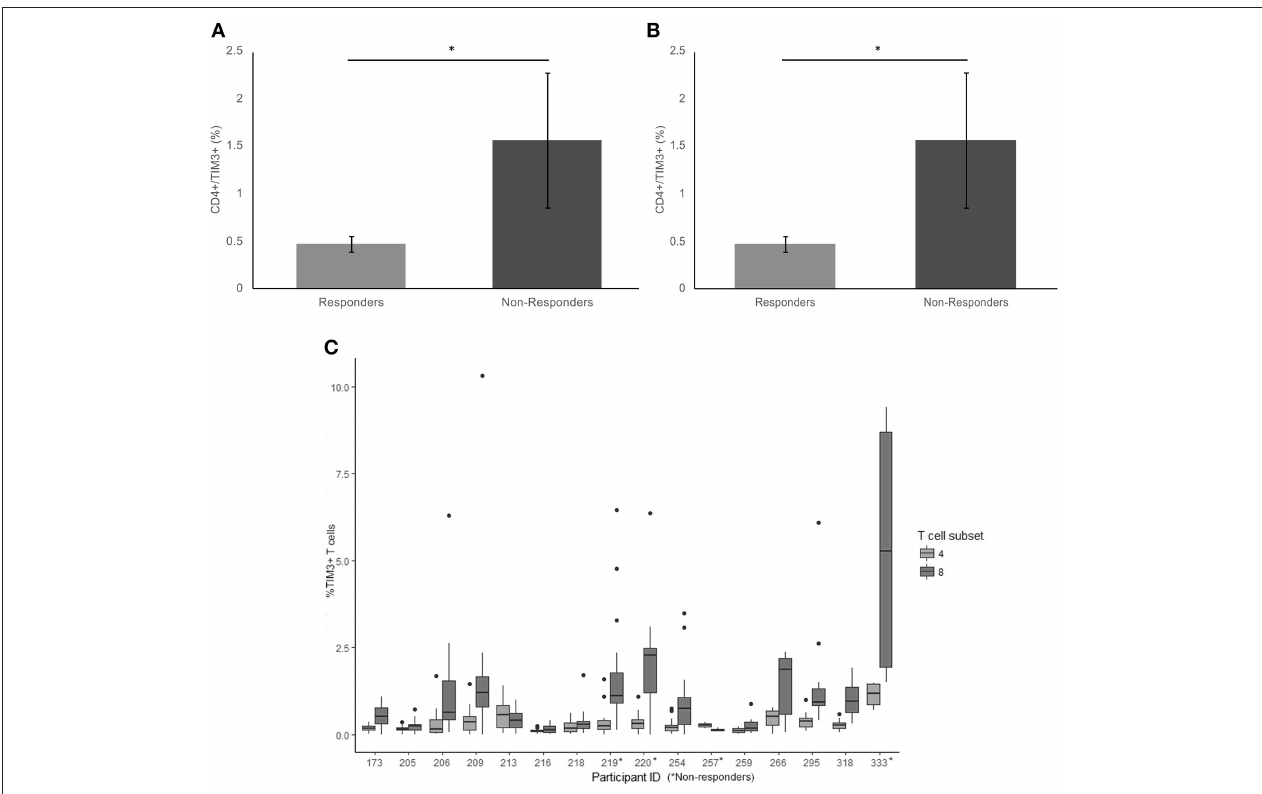
FIGURE 2 | Frequency of TIM3 expression on CD4 + and CD8 + T cells. (A) The mean percentage of CD4 + T cells expressing TIM3 in non-responders responders to pembrolizumab (B) The mean percentage of CD8 + T cells expressing TIM3 in non-responders responders to pembrolizumab (C) Boxplot of mean frequency of TIM3 on CD4 + and CD8 + T cells per patient per cycle. * p <